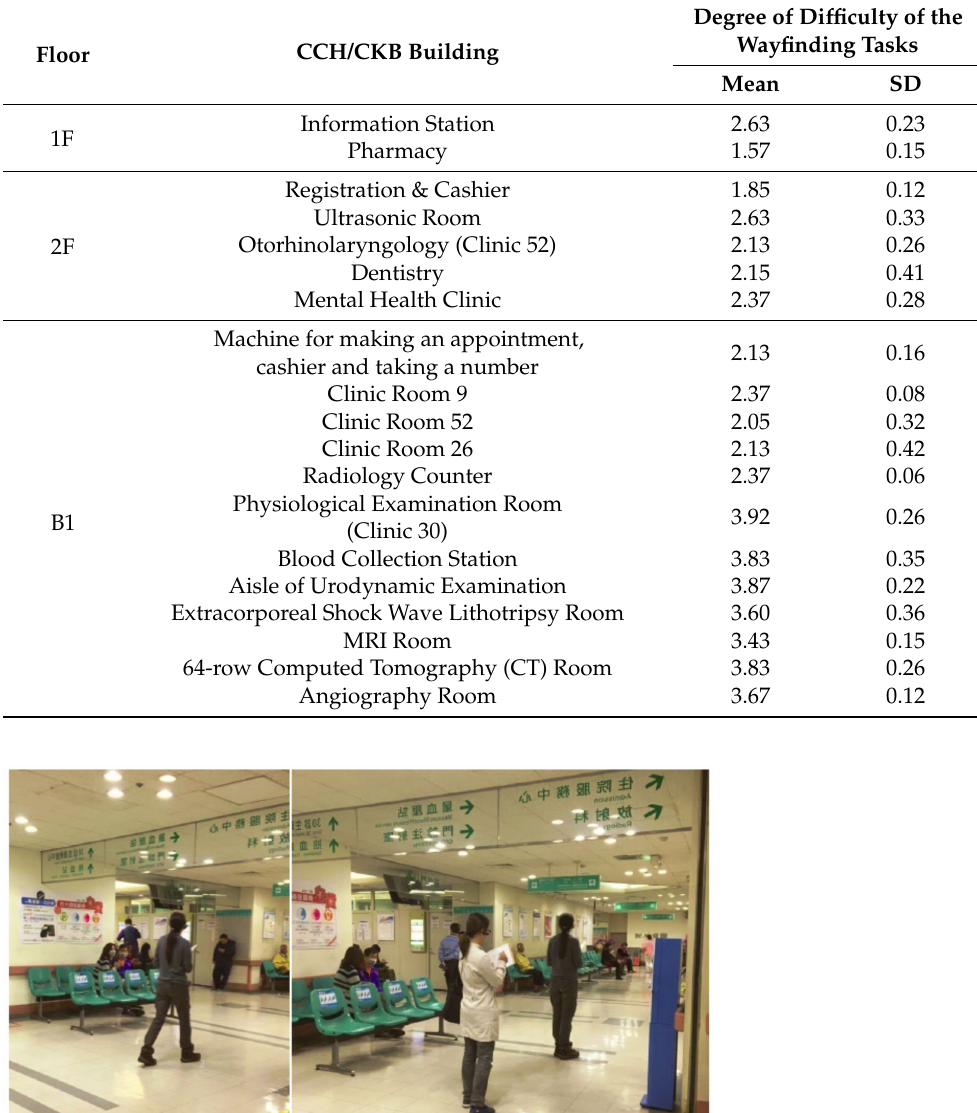
Table 5. Wayfinding task contents of the clinic and examination rooms in the different floors of the medical building.